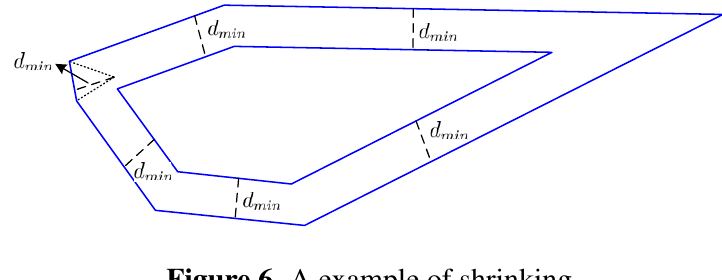
Figure 6. A example of